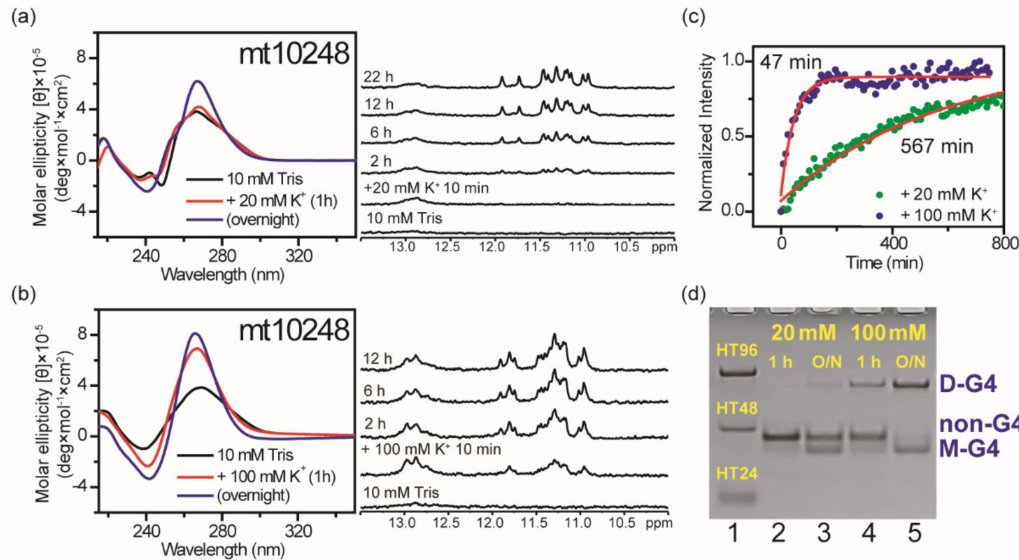
Figure 7. The [K + ] dependent study on the e ff ect of flanking nucleotides on G4 formation of mt10251-FN (mt10248). Time-dependent CD and NMR spectra of mt10248 in 10 mM Tris and after the addition of 20 mM K + ( a ) and 100 mM K + ( b ). The plots of arising CD signals at 265 nm of mt10248 fitted with single exponential after the addition of 20 mM K + and 100 mM K + ( c ). PAGE assays of marker bands of HT24 (T 2 AG 3 ) 4 , HT48 (T 2 AG 3 ) 8 , and HT96 (T 2 AG 3 ) 16 and mt10248 after 1h and O / N addition of 20 mM K + and 100 mM K + ( d ). The same DNA concentration of 100 µ M was used in the experiments of CD, NMR and PAGE of this